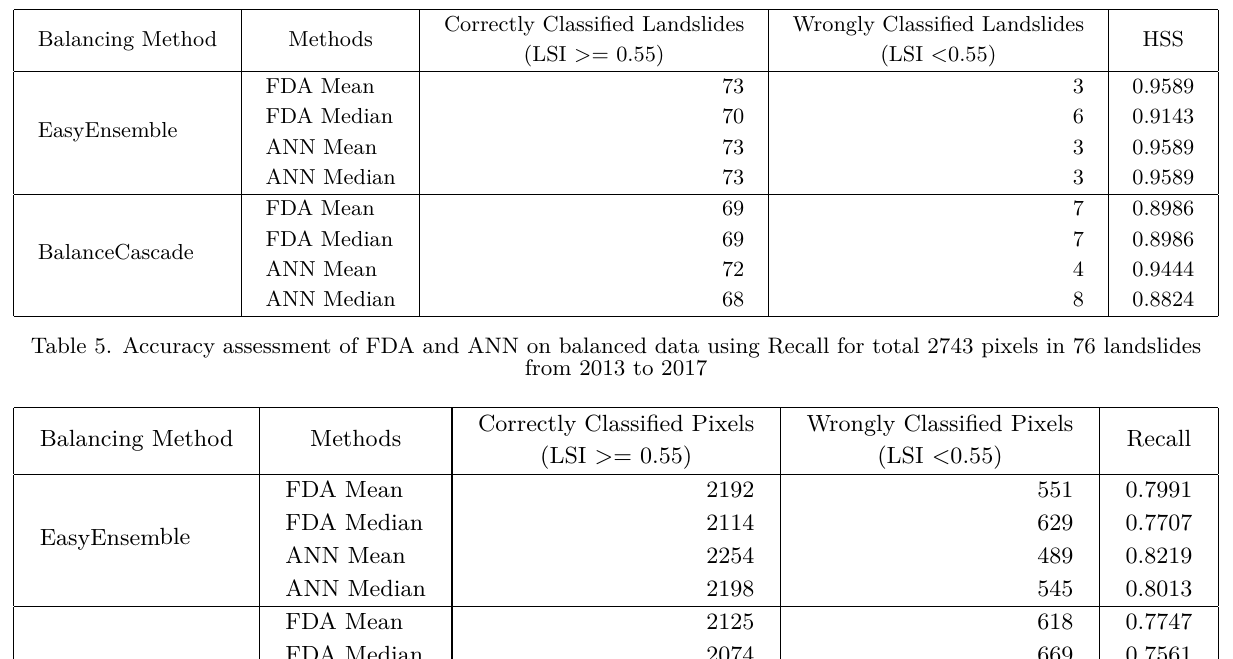
Table 4. Accuracy assessment of FDA and ANN on balanced data using Heidke Skill Score for total 76 landslides from 2013 to 2017